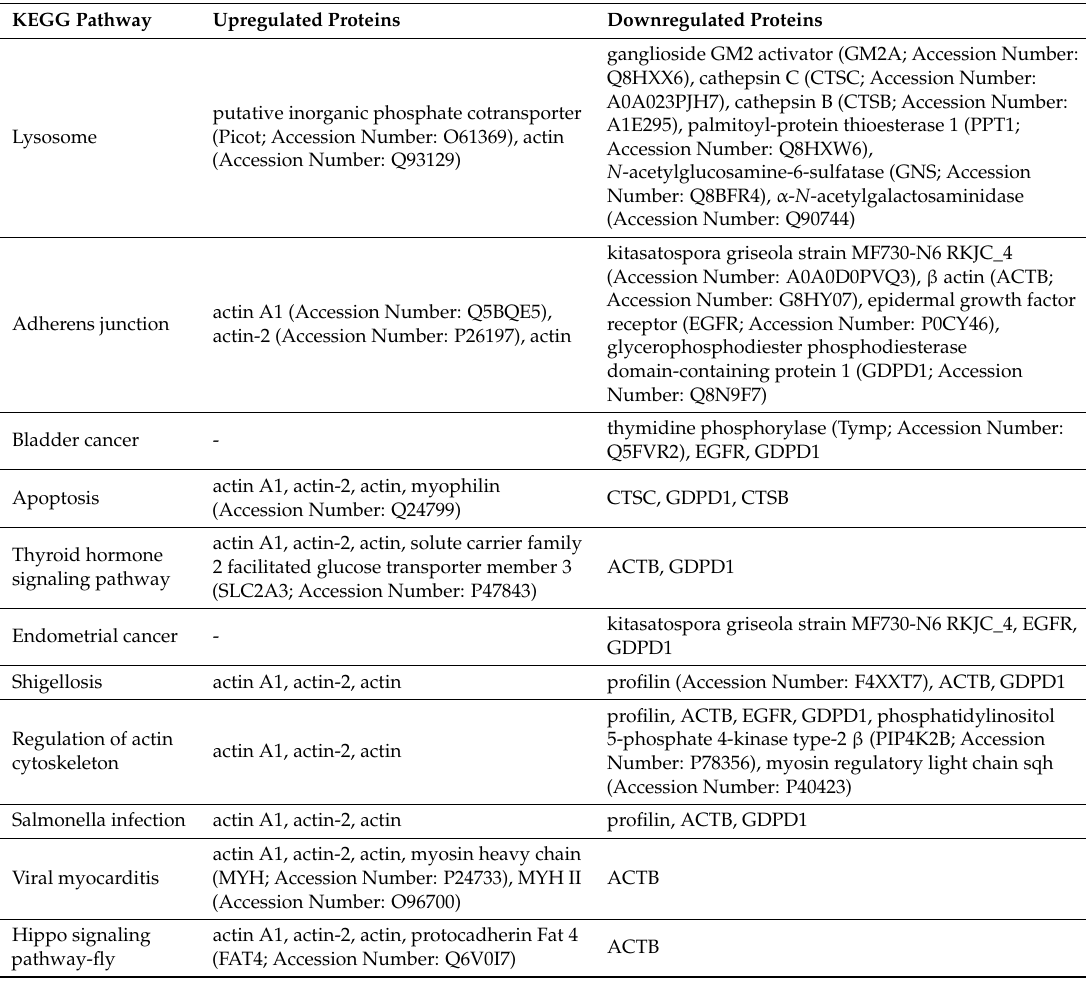
Table 2. Proteins differentially expressed in the large specimens of H. discus hannai , as compared to the small specimens in various significant Kyoto Encyclopedia of Genes and Genomes (KEGG)